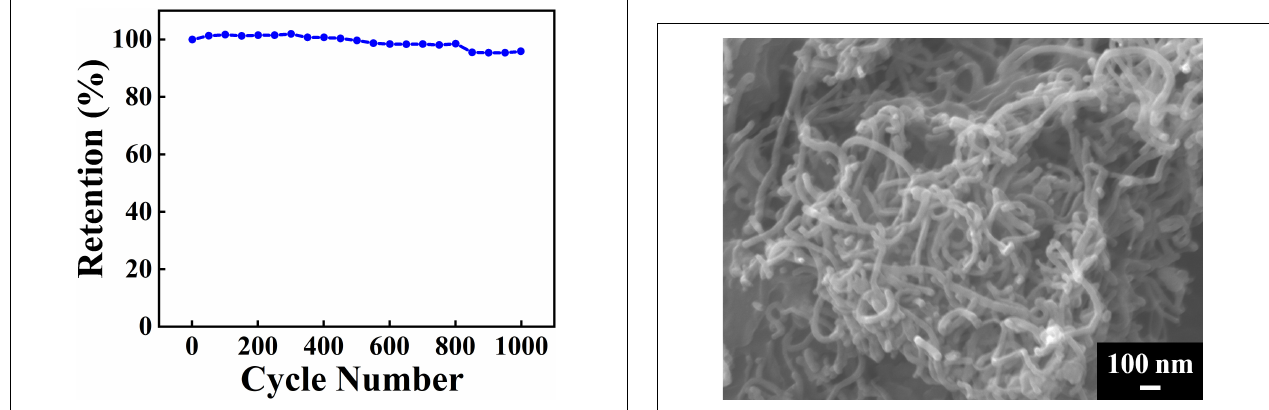
FIGURE 5 | Capacitance retention vs. cycle number for Zn-Fe-DH -MWCNT.